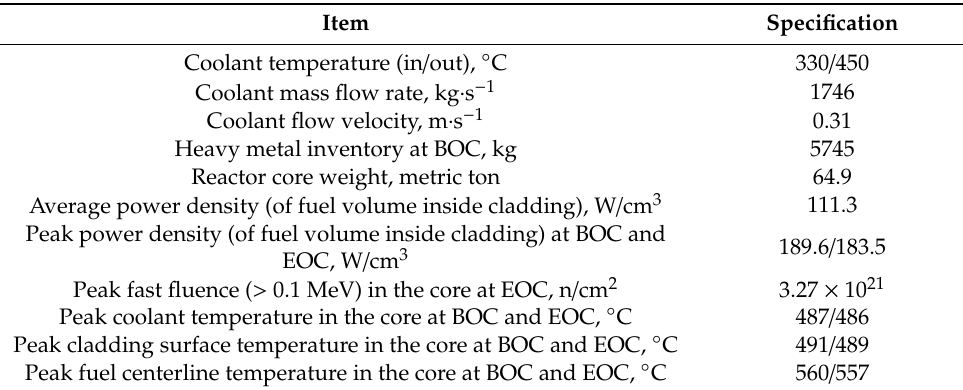
Table 4. Performance parameters of the reactor core design.